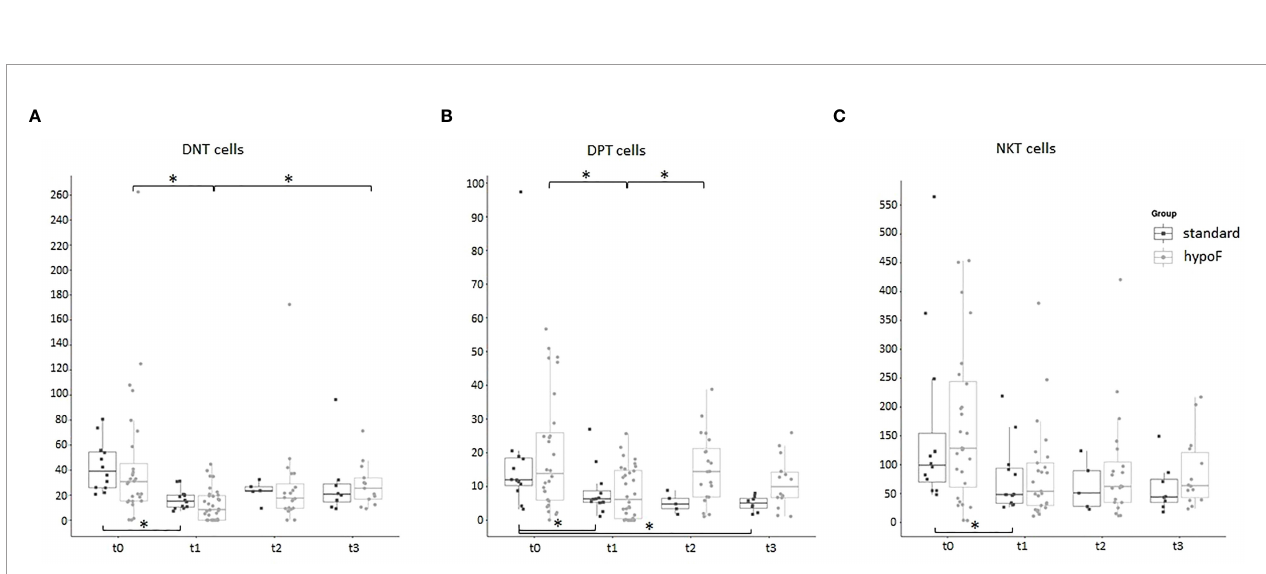
FIGURE 7 | Boxplots of the 3 small T-cell population values, expressed as cells/µl, in standard ( n = 12) and hypoF ( n = 32) RT groups during the four time points considered. (A) CD3+CD4-CD8-CD16-CD56- double-negative T cells (DNT); (B) CD3+CD8+CD4+ double-positive T cells (DPT); (C) CD3+CD16+CD56+ NKT cells. Statistically signi fi cant differences were marked (Wilcoxon test, *adjusted p -value <